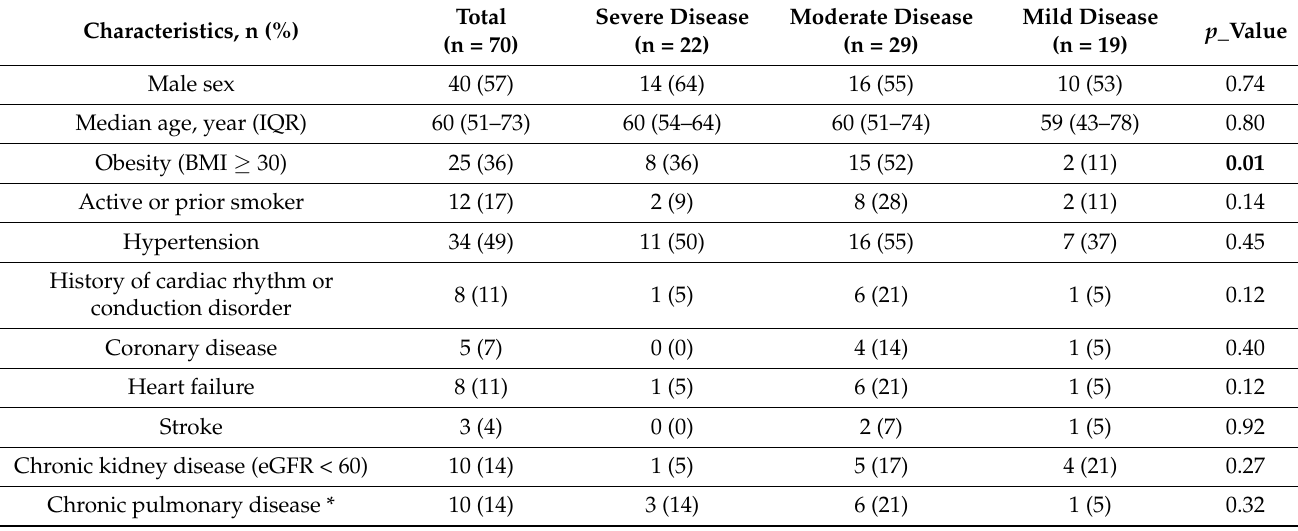
Table 1. The baseline demographic characteristics and comorbidities of